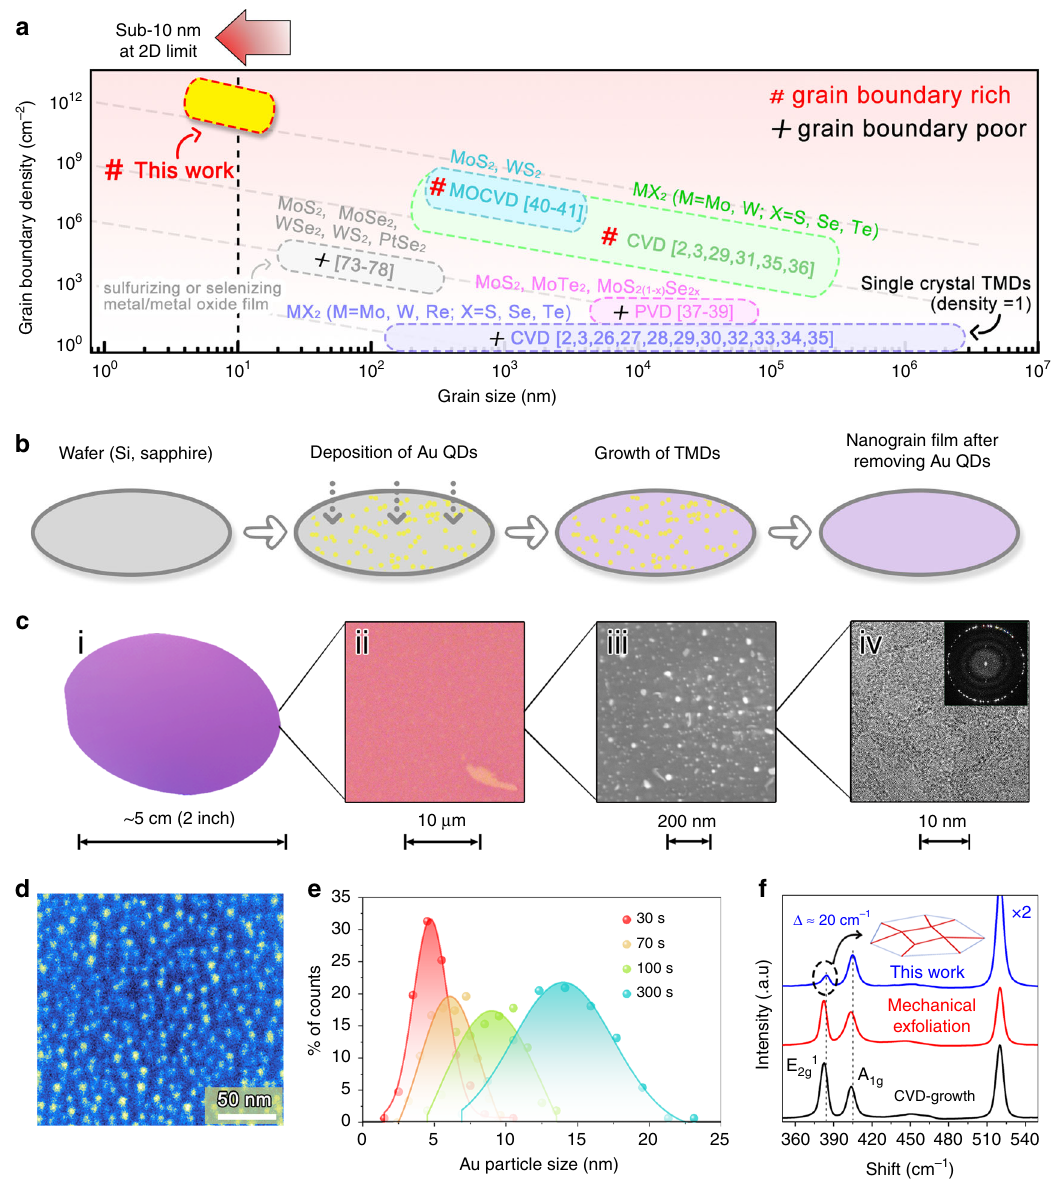
Fig. 1 Synthesis of wafer-size TMD nanograin fi lms. a Overview of the grain size and density in TMD materials obtained by various fabrication methods, such as CVD 2,3,26 – 36 , MOCVD 40,41 , PVD 37 – 39 , top – down syntheses of sulfurization/selenization of metal and metal oxide thin fi lms 73 – 77 , and thermal decomposition of thiosalts thin fi lms 78 . Although small grains (~20 nm in diameter) were observed in TMDs synthesized by the top – down methods of sulfurizing Mo-based thin fi lms 73,74 , or thermal-decomposition of Mo-thiosalts thin fi lms 78 , the grain density in the fi lm is not very high owing to their interlayer diffusion synthesis mechanism. b Schematic of the wafer-scale growth of TMD nanograin fi lms. Ultra-high-density Au quantum dots (QDs) were used to grow the MoS 2 (as well as WS 2 atom-thin fi lms: see Supplementary Information). c TMD nanograin fi lm from wafer scale to nanoscale, including photograph (i), optical image (ii), SEM image (iii), and HRTEM image (iv). d False-colored SEM image of the Au QDs on a SiO 2 /Si substrate, showing an average diameter of 4.8 nm. e Statistical distributions of Au QDs obtained from Au fi lms with different deposition times. The evaporation rate is ~0.1 Å s − 1 in our experiments. f Raman spectra acquired from the MoS 2 fi lm. The difference ( Δ ~20 cm − 1 ) between the out-of-plane (A 1g ) and in-plane (E 1 2g ) Raman modes indicates that the MoS 2 fi lm is 1 – 3 layers (1 – 3 L) 2,44 . Compared to CVD-grown and exfoliated samples, the reduced intensity of the in-plane mode indicates a highly polycrystalline structure for this MoS 2 fi Supplementary Fig. 9. The inspection of dozens of boundary found, but in contrast, 12|4 rings were never observed in “ pristine ” GBs (i.e., before any substantial exposure to the locations systematically found that nanograins in our fi lms are stitched by GBs. The atomic structure of the GBs varied electron beam). Their atomic structures in MoS 2 are schemati- cally illustrated in Supplementary Fig. 10. signi fi cantly (great care was taken to exclude any structure Although the nature of atomic-resolution microscopy pre- modi fi cation arising from beam damage, see Experimental section cludes large-scale statistical studies, we investigated as many for details). Structures comprising a combination of 5|7 and 6|8 different regions in a MoS 2 nanograin fi lm as practically possible. rings were however dominant in our nanograin fi lms and are Six further regions over a large range were carefully examined illustrated in Fig. 2c. A small number of 8|4|4 structures were